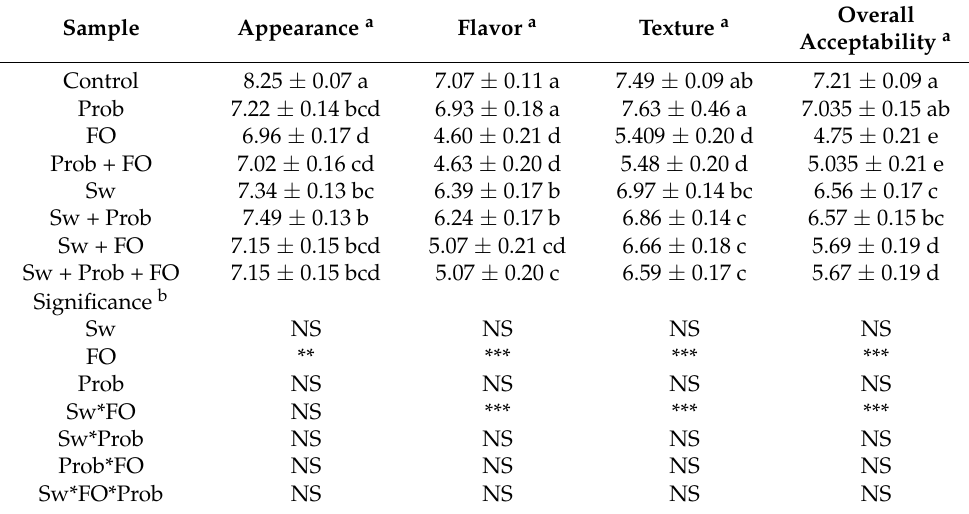
Table 4. Sensory acceptability values of milk chocolate and sugar-free milk chocolate formulations with added probiotics and fish